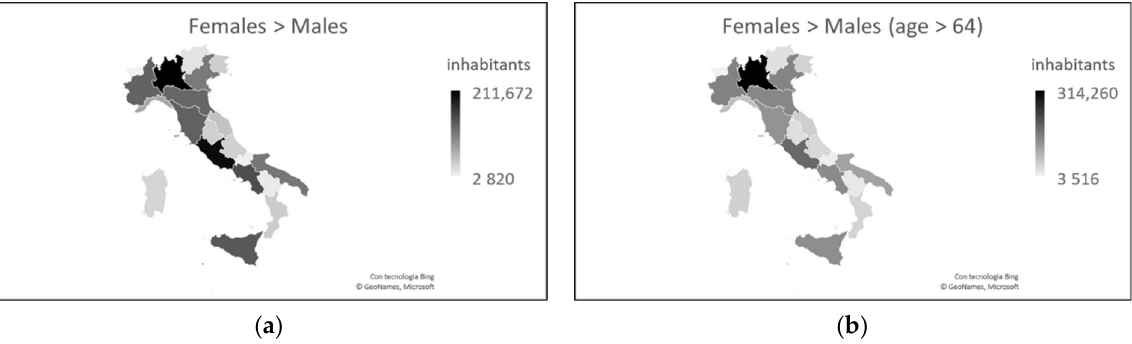
Figure 4. Distribution of the male and female populations in Italy, overall ( a ) and only for the age group > 64 years ( b ) (updated to 2019).